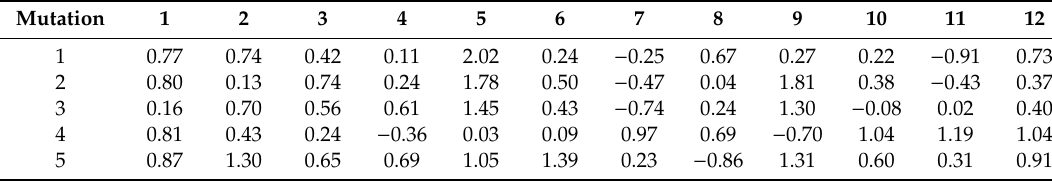
Table 6. Mutant vectors of sample problems in round 1.